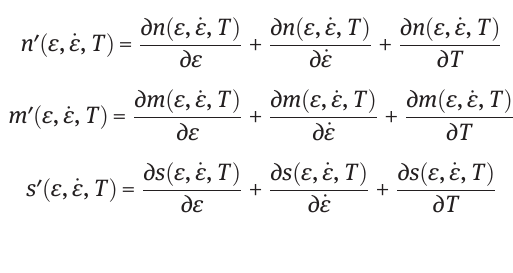
Figure 9: n, m, s changing with strain, strain rate and temperature: (a) n ð ε Þ , n ð _ ε Þ , n ð T Þ ; (b) m ð ε Þ , m ð _ ε Þ , m ð T Þ ; and (c) s ð ε Þ , s ð _ ε Þ , s ð T Þ